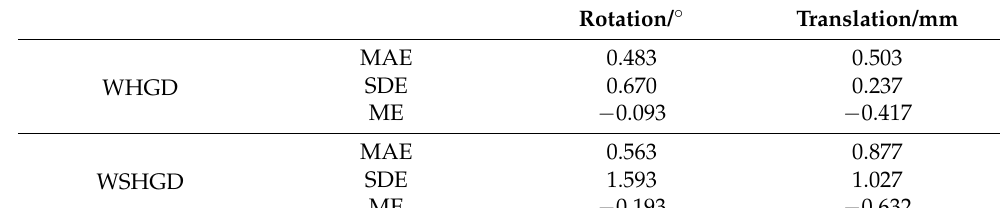
Figure 6. Result of Experiment 3: ( a ) reference image 3; ( b ) DRR image based on WSHGD registra- tion; ( c ) difference image after registration based on the WSHGD; ( d ) reference image 3; ( e ) DRR image registered based on WHGD; ( f ) difference image after registration based on the WHGD.